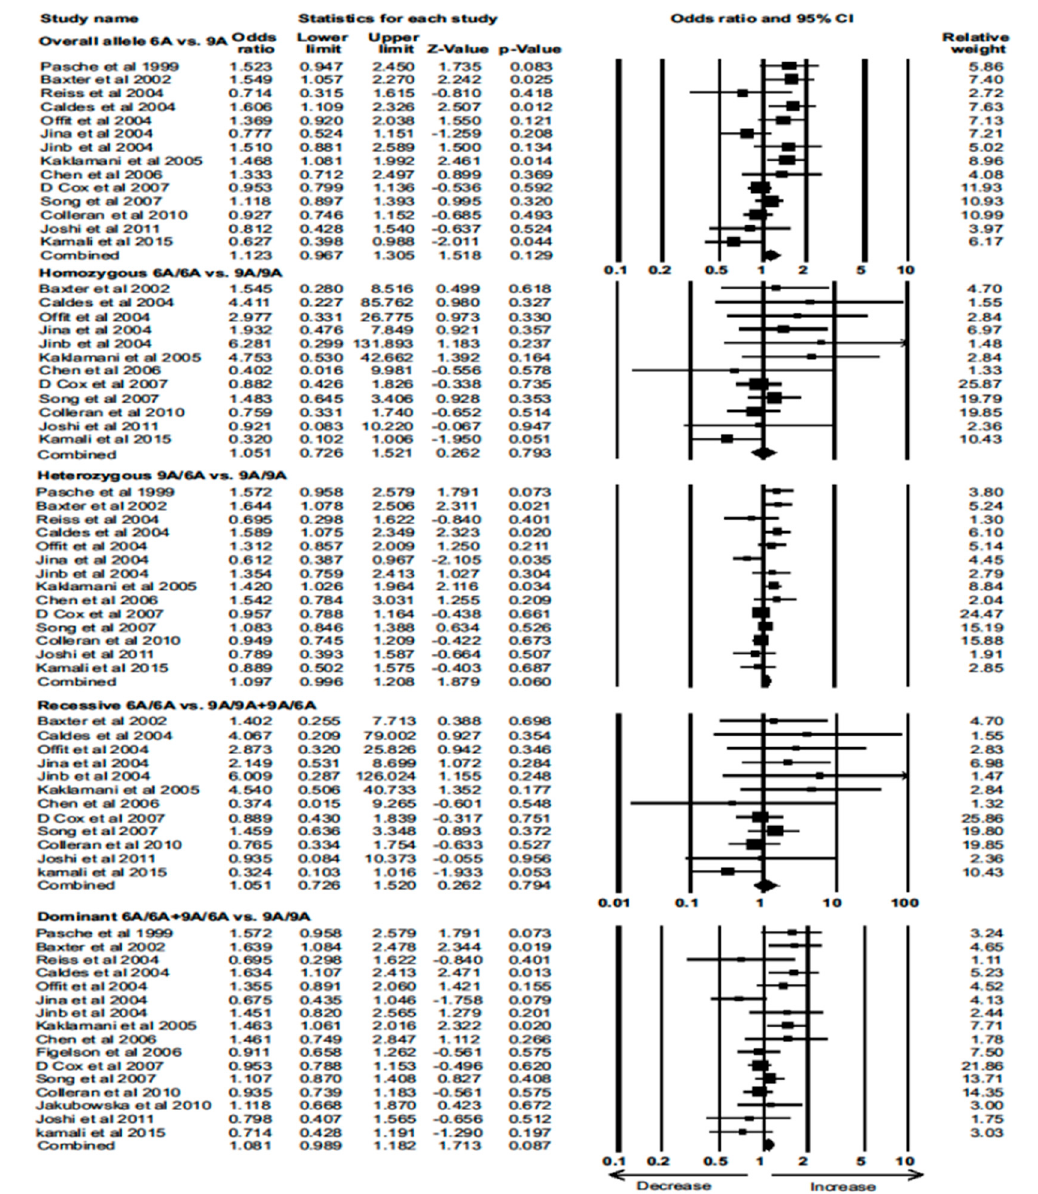
Figure 4. Forest plot of overall allele and genotypic analyses of the TGF- β 1*6A polymorphism and assessment of its association with BC risk using pooled combined odds ratios (ORs) and 95% confidence intervals (CIs) of the ORs. Black squares represent the ORs of the individual studies, and horizontal lines indicate the 95% CIs of the ORs.